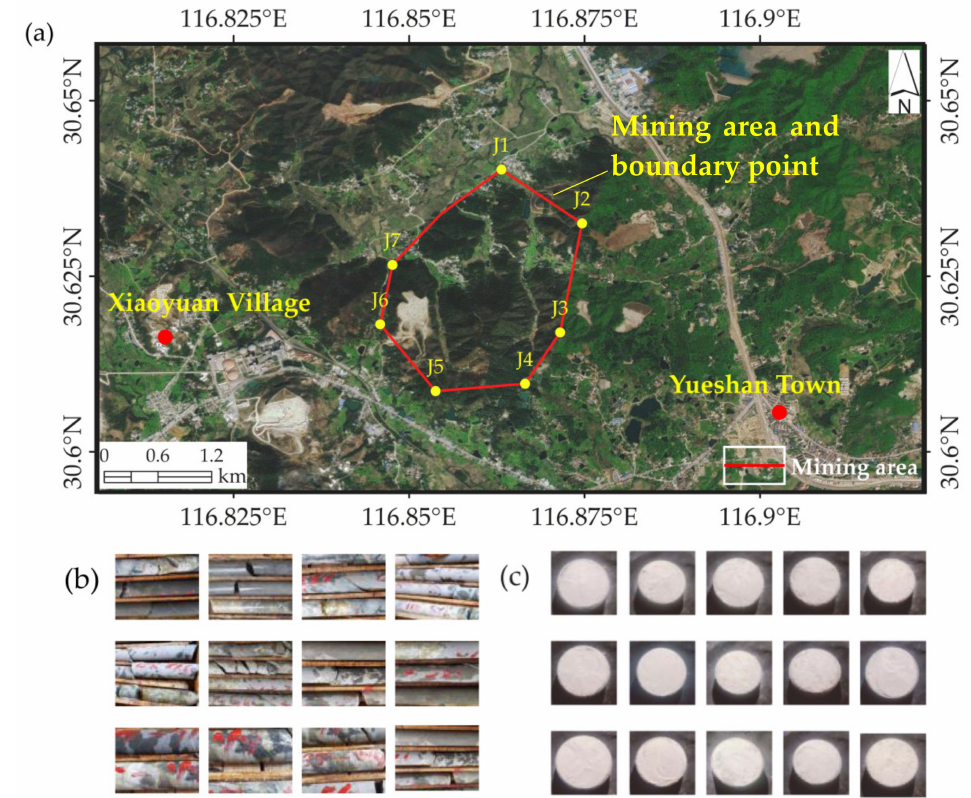
Figure 1. ( a ) Location of the study area in Xiaoyuan village, Yueshan Town, Huaining County, Anhui Province, China. ( b ) The cores from different construction boreholes in copper deposits. ( c ) A part of the copper ore samples processed by the crusher and the grinding